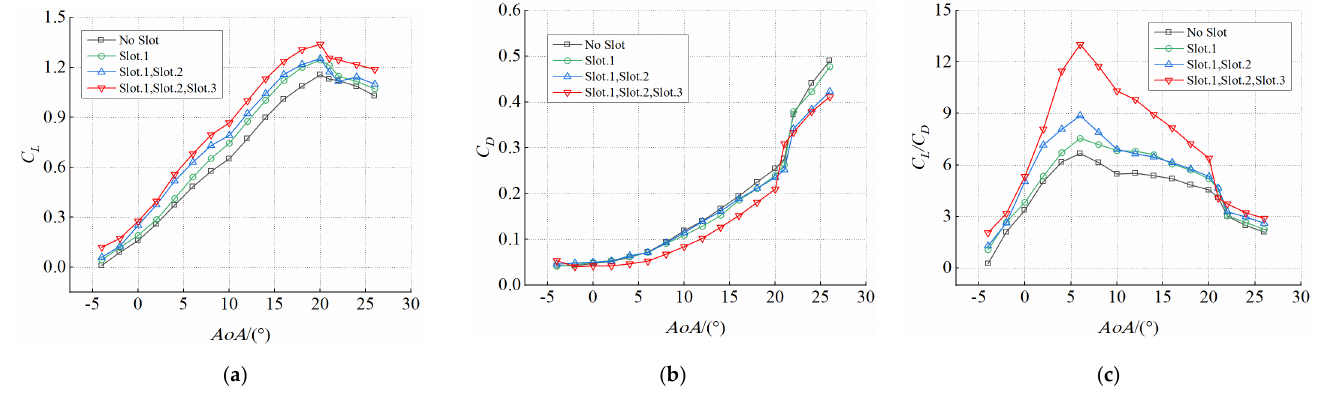
Figure 6. Comparison of wing aerodynamic characteristics with different numbers of slots ( U ∞ = 8 m/s and Q = 41.91 m 3 /h). ( a ) Lift coefficient. ( b ) Drag coefficient. ( c ) Lift-to-drag ratio.